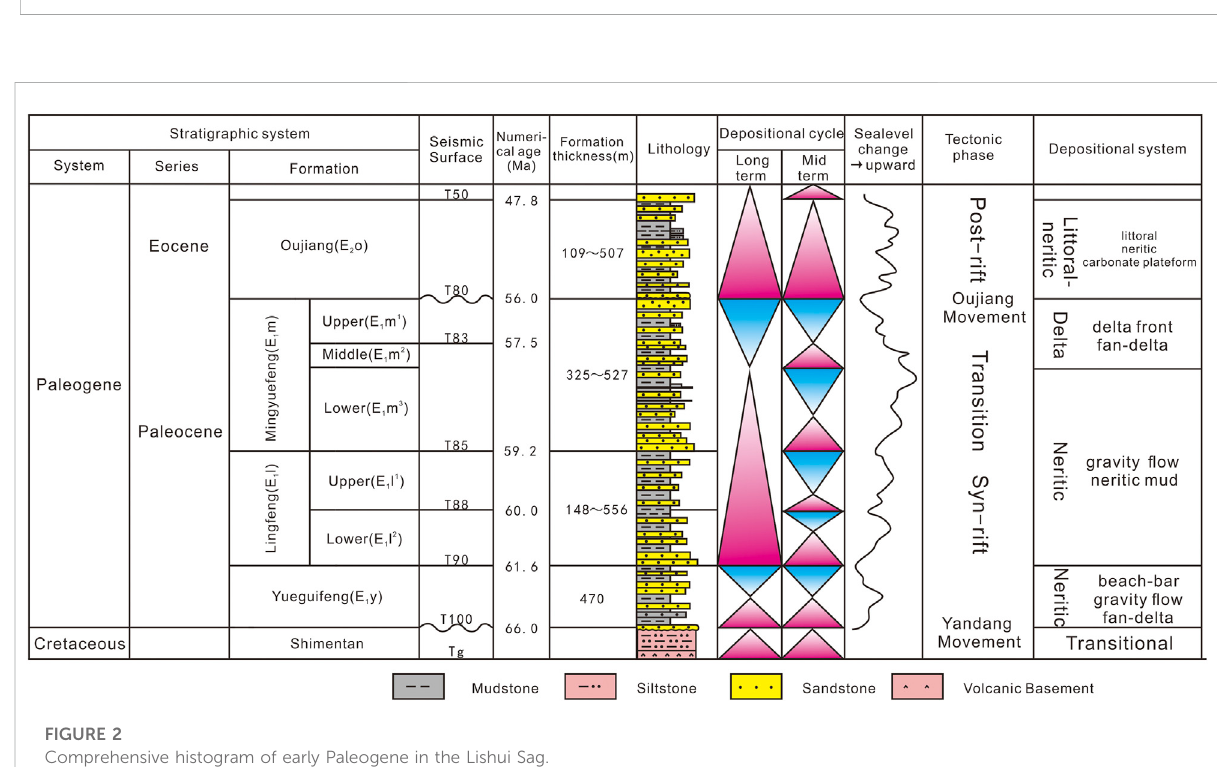
FIGURE 2 Comprehensive histogram of early Paleogene in the Lishui